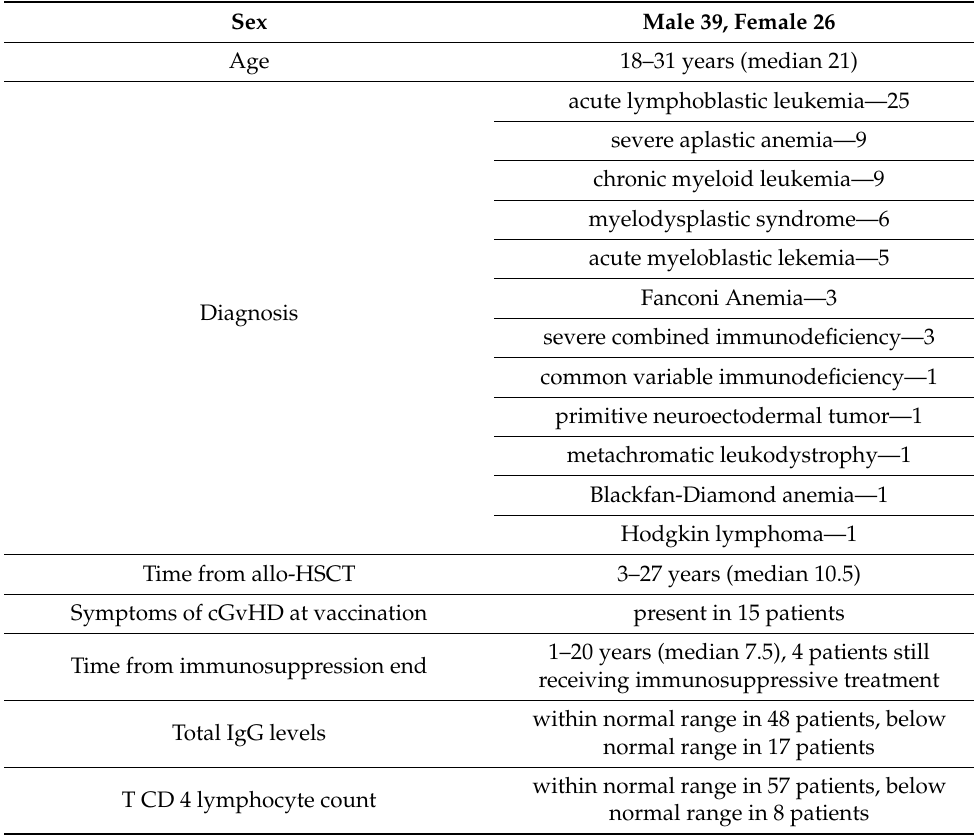
Table 1. Basic information about the patients.